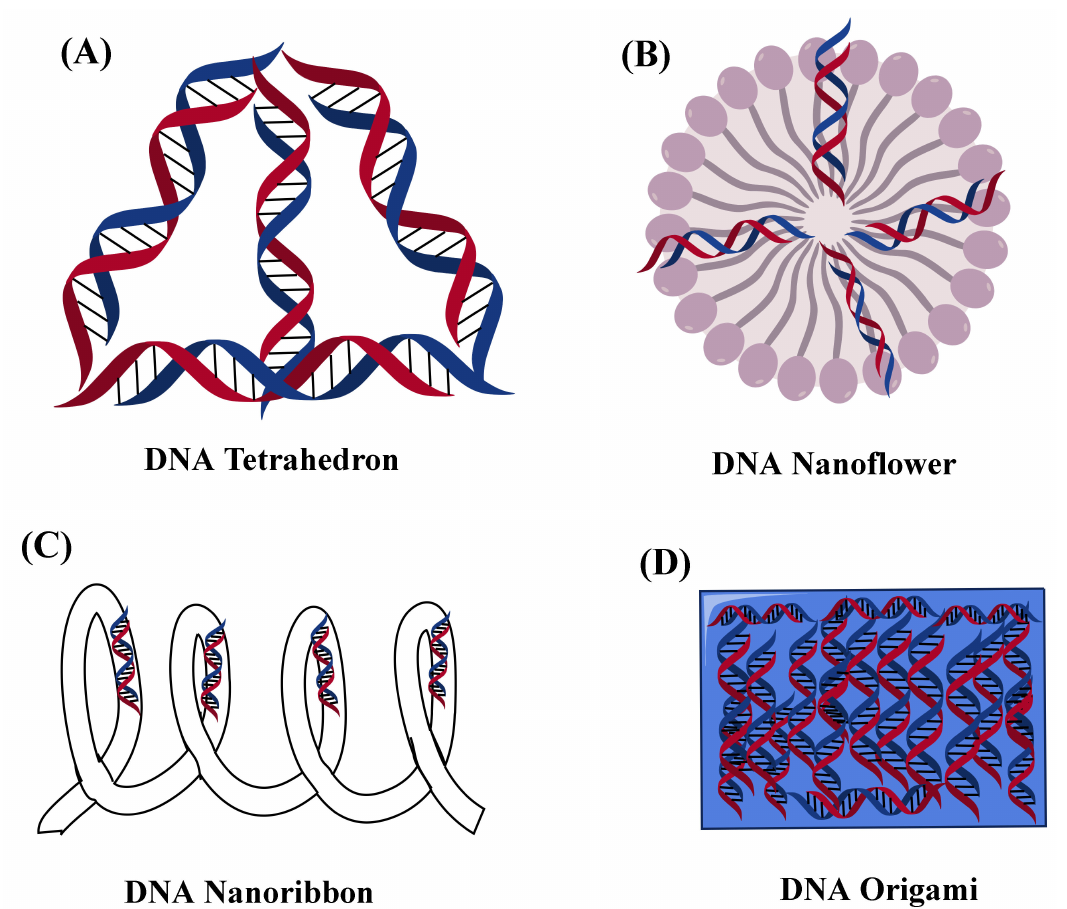
Figure 2. Showed the nanostructure representation of different types of DNA ( A ) DNA tetrahedron, ( B ) DNA nanoflower, ( C ) DNA nanoribbon, and ( D ) DNA